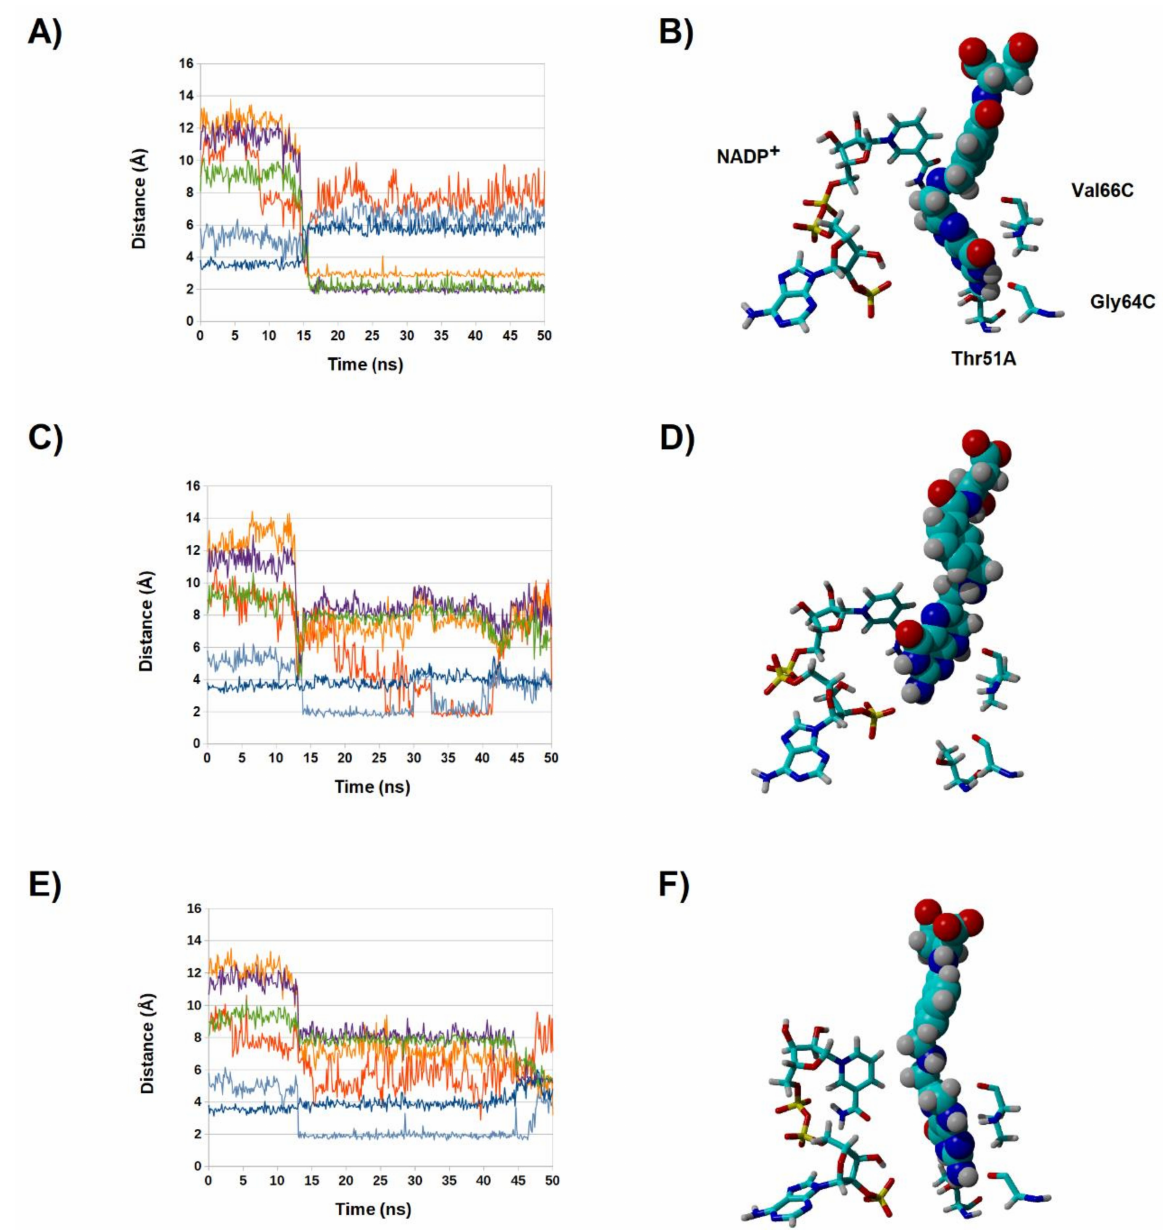
Figure 5. Evolution of key distance between N 5 -protonated dihydrofolate and R67 DHFR along multiple simulations ( A , C , E ). Light-green: distance between 2 (cid:48) -phosphate and folate N 3 -H; violet: distance between 2 (cid:48) -phosphate and folate NH 2 group; light blue: distance between Val66 NH and folate N 1 ; dark blue: distance between Gly64 C=O and folate NH 2 ; orange: distance between Lys32C and folate glutamyl carboxylate; red: Lys32D and folate glutamyl carboxylate. ( B , D , F ): the final poses obtained at the end of each 50 ns simulation. Most amino acids have been hidden for